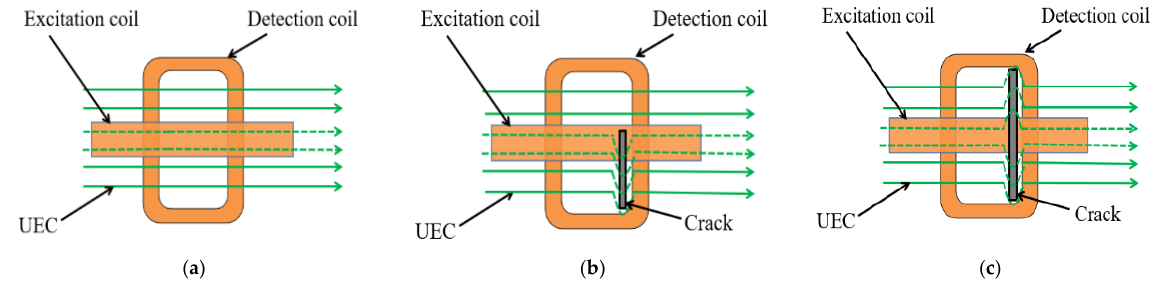
Figure 1. The test schematic diagram of the traditional UEC probe: ( a ) no crack defect; ( b ) asymmetric crack defect; ( c ) symmetrical crack